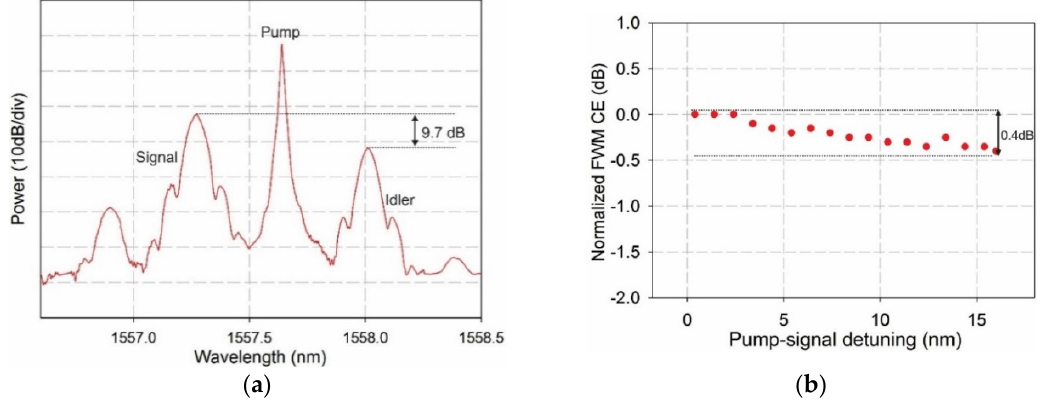
Figure 9. ( a ) Output optical spectrum of the wavelength converter; and ( b ) normalized FWM conversion efficiency (dB) as a function of pump ‐ signal detuning (nm).